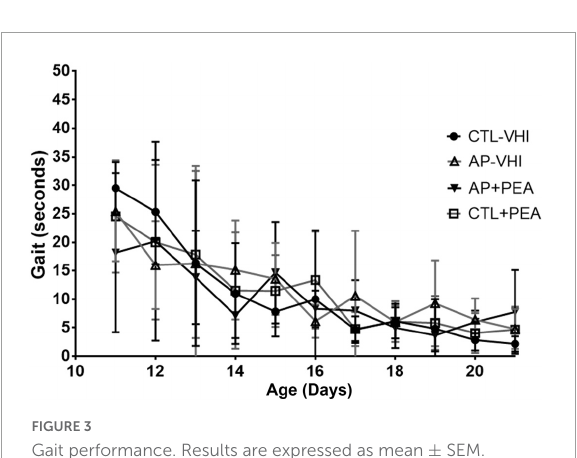
FIGURE3 Gait performance. Results are expressed as mean ± SEM. CTL-VHI, control rats treated with vehicle; PA-VHI, rats subjected to PA and treated with vehicle; PA + PEA, rats subjected to PA and treated with PEA; CTL + PEA, control rats treated with PEA.